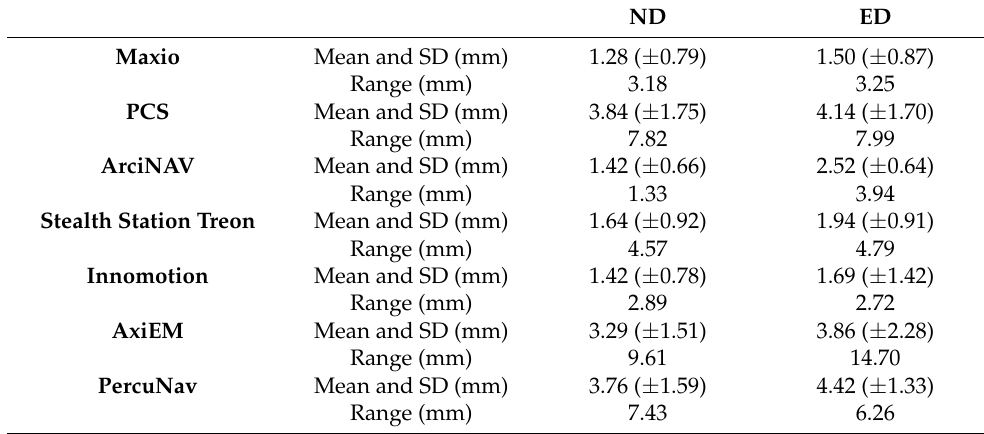
Table 3. Comparison of the accuracy of the Maxio and PCS to the previously reported results of our group. Venturi et al. [12] investigated the accuracy of the ArciNav patient-specific template based guidance system; Stoffner et al. [11] used the Stealth Station Treon optical navigation system in combination with an aiming device and the Innomotion robot; and Putzer et al. [13] tested the AxiEM and the PercuNav electromagnetic navigation